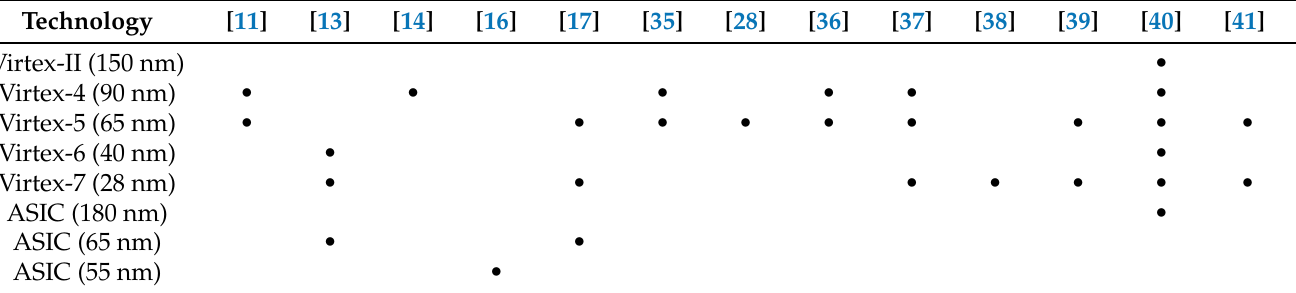
Table 5. Type of Integrated Circuit (IC) technology used for E ( F 2 163 )